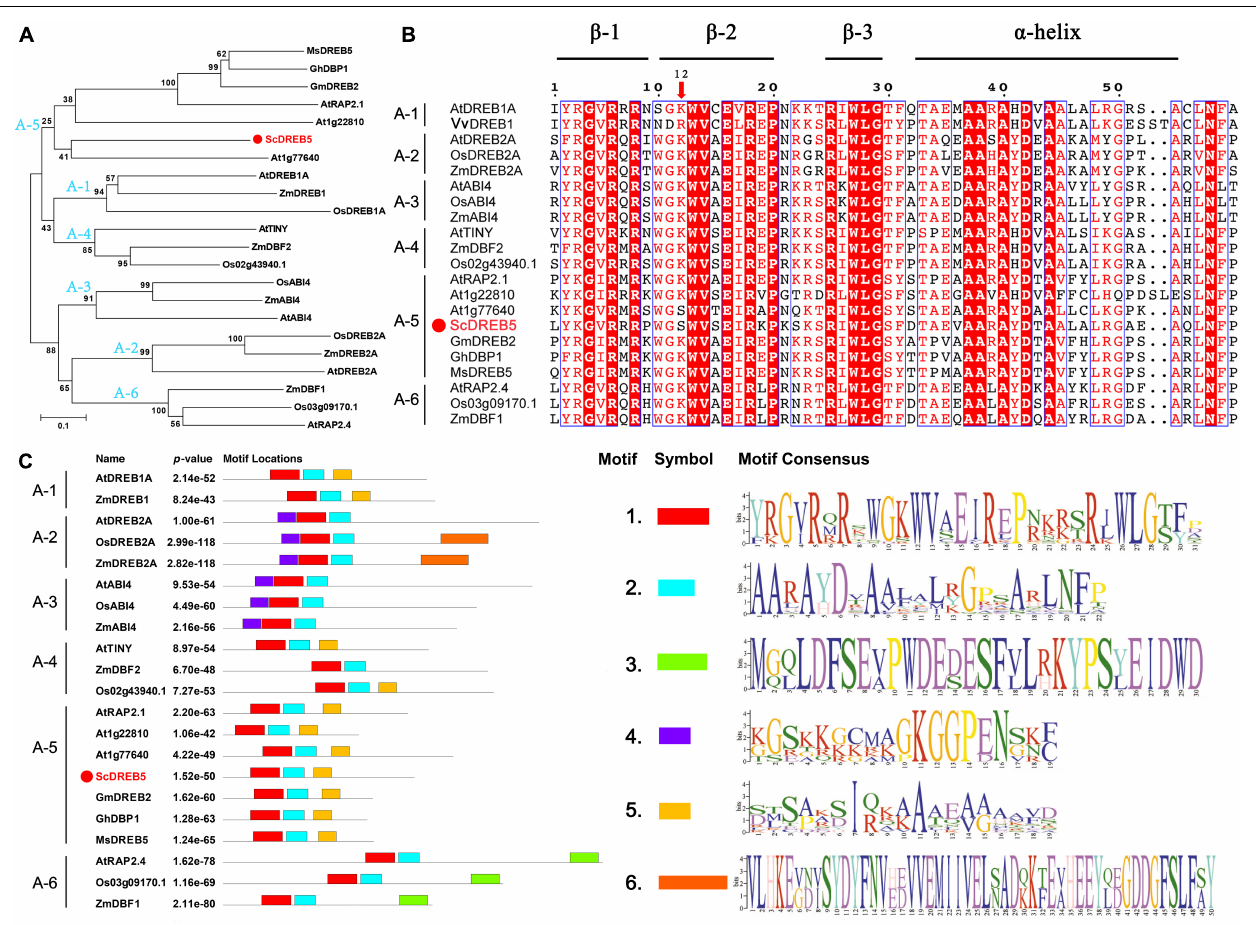
FIGURE 1 | Phylogenetic analysis, sequence alignment and motif prediction of ScDREB5. (A) Phylogenetic analysis of ScDREB5 with DREBs from different plant species. A phylogenetic tree was constructed using the neighbor-joining method with Poisson correction (pairwise deletion), and bootstrap values from 1000 replicates were used to assess the robustness of the tree. (B) Multiple sequence alignment of ScDREB5 with other classic DREB proteins from different plants. (C) Motif prediction of ScDREB5 with other classic DREB proteins. The red color highlights the same amino acid sequence. All amino acid sequences were retrieved from GenBank: S. caninervis ScDREB5 (AMT92113.1); A . thaliana AtDREB1A (BAA33791), AtDREB2A (BAA33794), AtABI4 (ABE65896.1), AtTINY (NP_197953.1), AtRAP2.1 (OAP00017.1), AT1G22810 (ABD57508.1) AT1G77640 (AAT06448.1), AtRAP2.4 (NP_177931.1); O . sativa , OsDREB2A (AFB77198), OsABI4 (C7J2Z1.1), Os02g43940.1 (XP_015626317.1), Os03g09170.1 (XM_015773644.2); V . vitis-idaea VvDREB1 (AFC89543.1); Z . mays ZmDREB2A (PWZ08831.1), ZmABI4 (KJ727241.1), ZmDBF2 (AAM80485.1), ZmDBF1 (AAM80486.1); M . sieversii MsDREB5 (AFM84627.1), G. max GmDREB2 (ABB36645.1); G. hirsutum